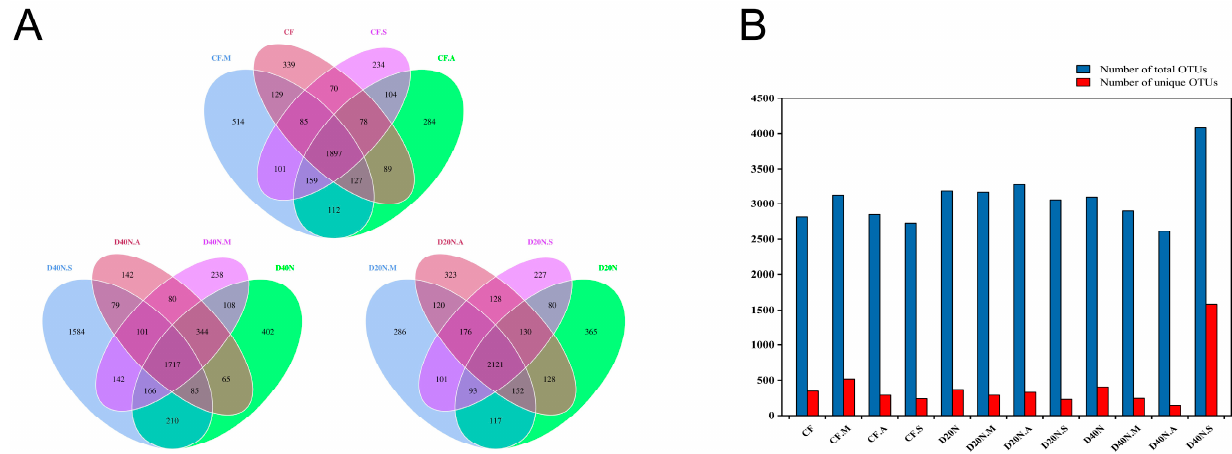
Figure 3. Comparison of bacterial communities in different treatments. ( A ) Venn diagram for treatments among different combinations. Every circle indicates a treatment, the numbers of OTUs shared between different treatments was interpreted with the number in the overlapping circles, while the number in the non-overlapping area represented the number of unique OTUs of the specific treatment. ( B ) Statistics of the OTU numbers in different treatments. Total OTUs referred to all the OTUs in a certain treatment. Unique OTUs were the ones (in a certain treatment) that were exclusive compared with other treatments.